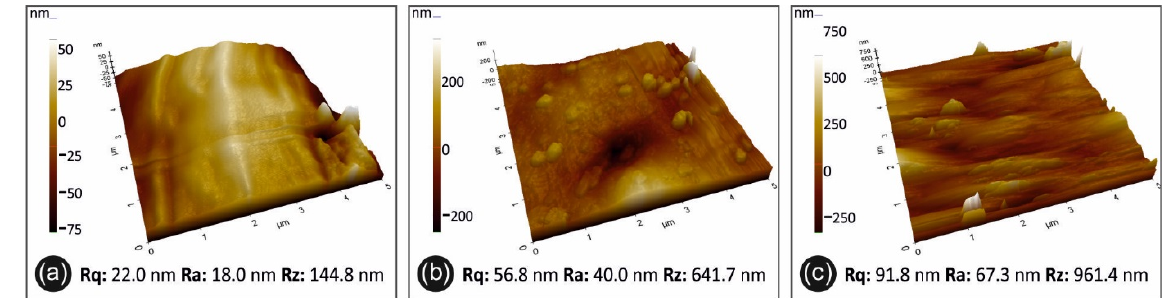
Figure 10. AFM images of the filaments’ side surface for the different materials in this study: ( a ) PP/SiO 2 0.5 wt.%, ( b ) PP/SiO 2 2.0 wt.%, ( c ) PP/SiO 2 4.0 wt.%.